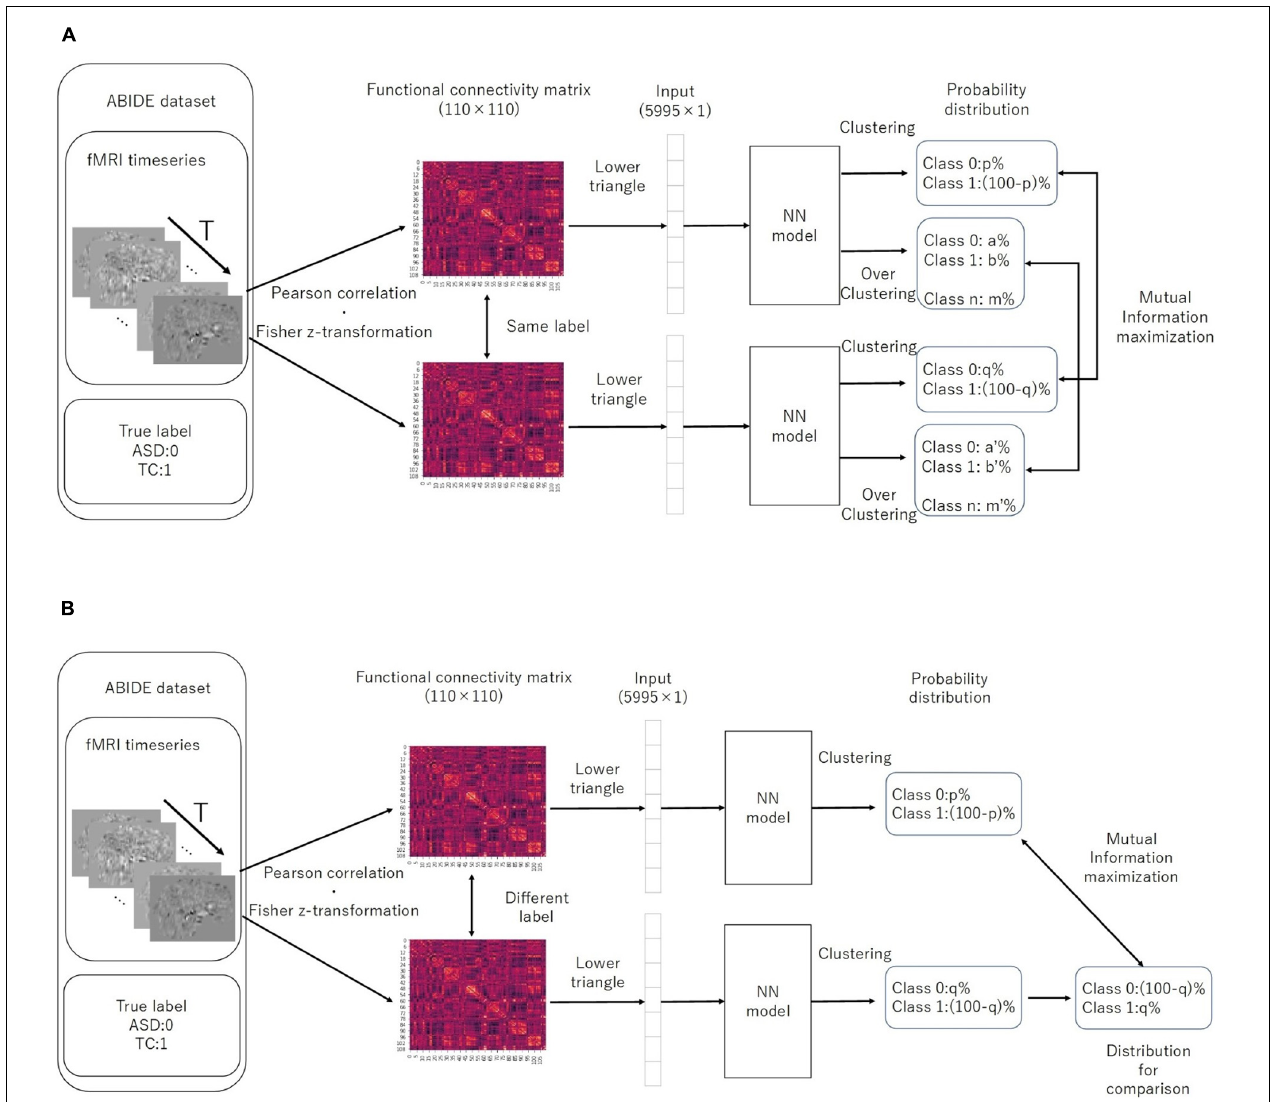
FIGURE 2 | Computation of IIC-loss for pairs with similar (A) and different (B) correct labels. IIC, invariant information clustering. The multi-class is assumed at the overclustering head output. In our method, data pairs for contrastive learning were based on single data labels instead of with a data augmentation